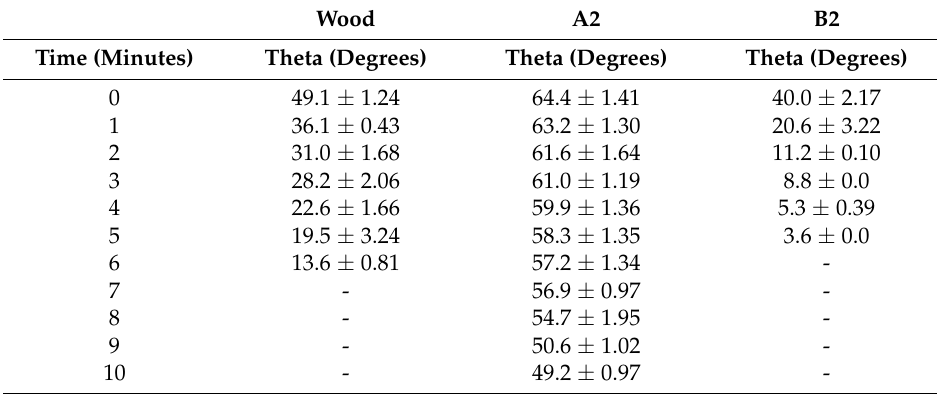
Table 4. Water contact angle theta on glucose (A2) and sucrose (B2) NIPU resins cured at 130 ◦ C